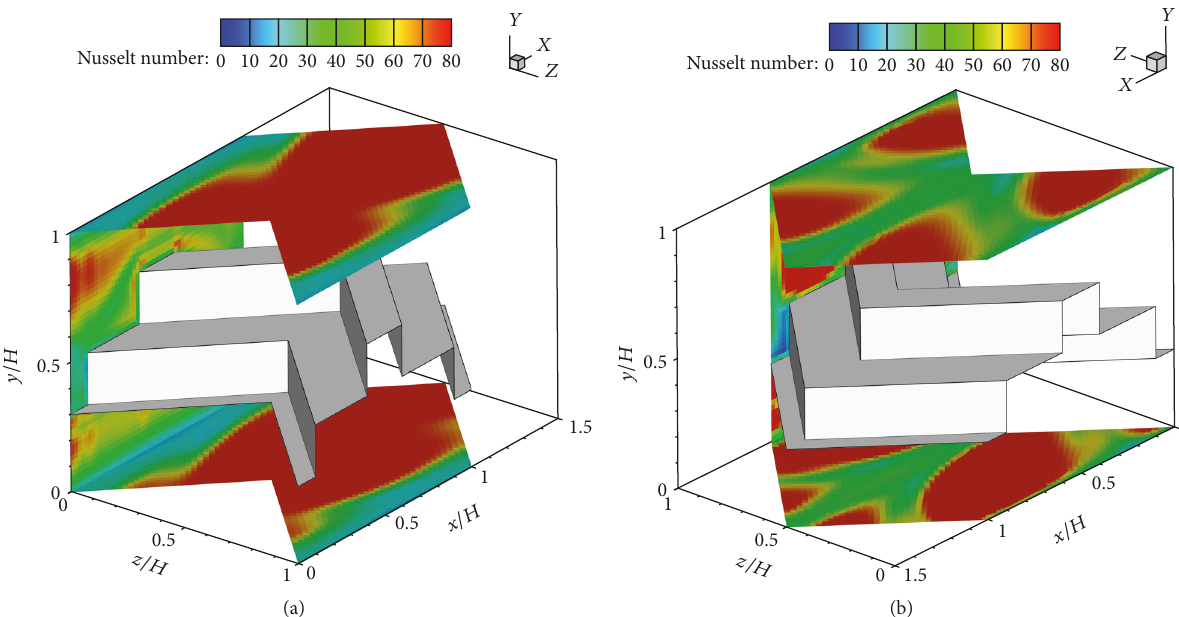
Figure 9: Local Nusselt number distribution on the wall surface of the square channel heat exchanger inserted with 45 ∘ V-wavy plate at Re = 3000 for (a) V-Downstream and (b) V-Upstream.